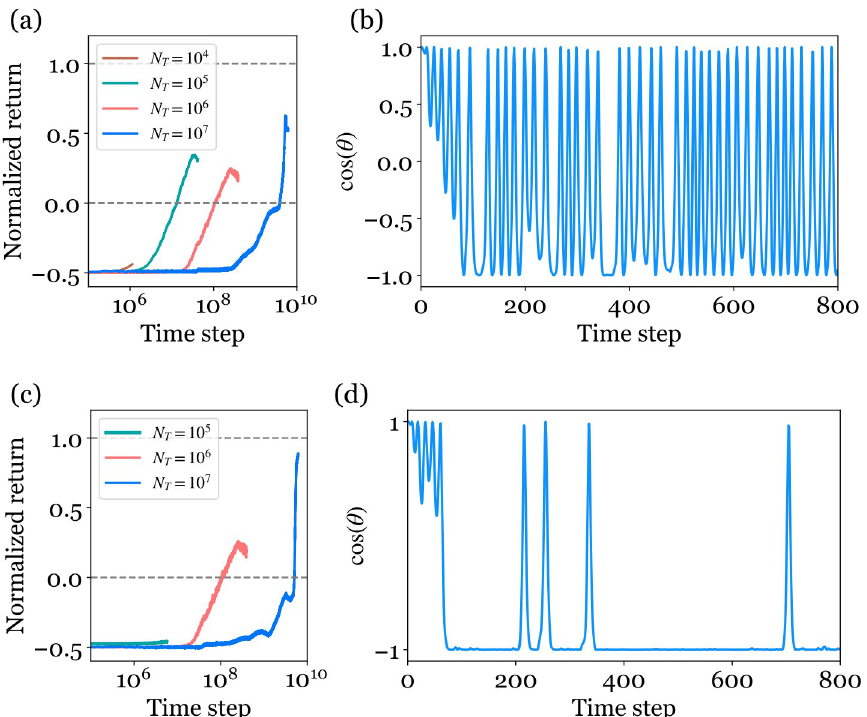
Fig 4. Learning results using the basic tabular Q-learning implementation. Left: Normalized return as a function of the number of time steps for different total number of episodes N T . Right: Temporal evolution of cos θ in the best = 10 7 ). The observation space ð sin ð y Þ ; cos ð y Þ ; _ y ; x ; _ x Þ is discretized episode of the longest learning process ( N T homogeneously into different number of bins: a) and b) nBins = (10, 10, 10, 10, 10), c) and d) nBins = (50, 50, 50, 10,